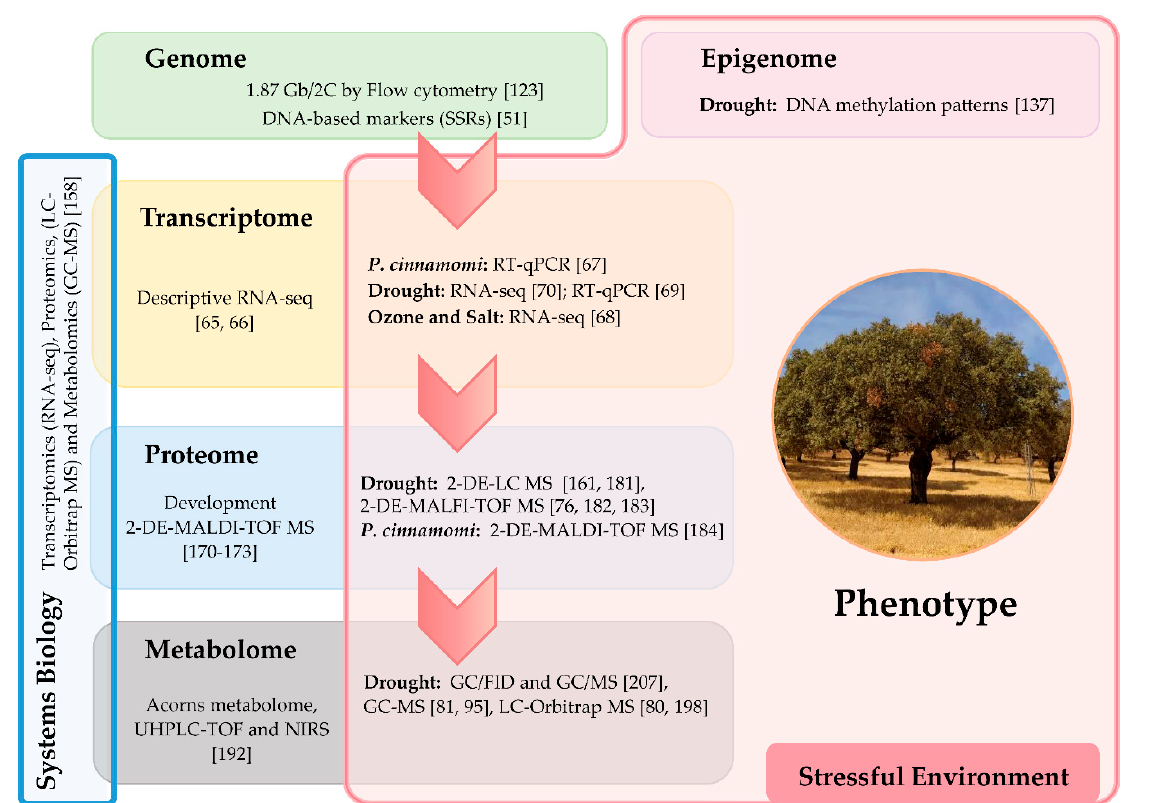
Figure 1. Central Dogma of Molecular Biology and omic cascade in Quercus ilex to characterize the responses to biotic and abiotic stresses using molecular approaches. The studies analyzed under stress in the different omics are located within the red “stressful environment” box. Abbreviations: Simple Sequence Repeats, SSRs; RNA sequencing, RNA-seq; Reverse Transcription-quantitative PCR, RT-qPCR; 2-dimensional gel electrophoresis, 2-DE; Matrix-Assisted Laser Desorption/Ionization, MALDI; time-of-flight, TOF; Mass Spectrometry, MS; Liquid Chromatography, LC; Ultra High-Performance Liquid Chromatography, UHPLC; near infrared spectroscopy, NIRS; Gas Chromatography, GC; and Flame Ionization Detector, FID.